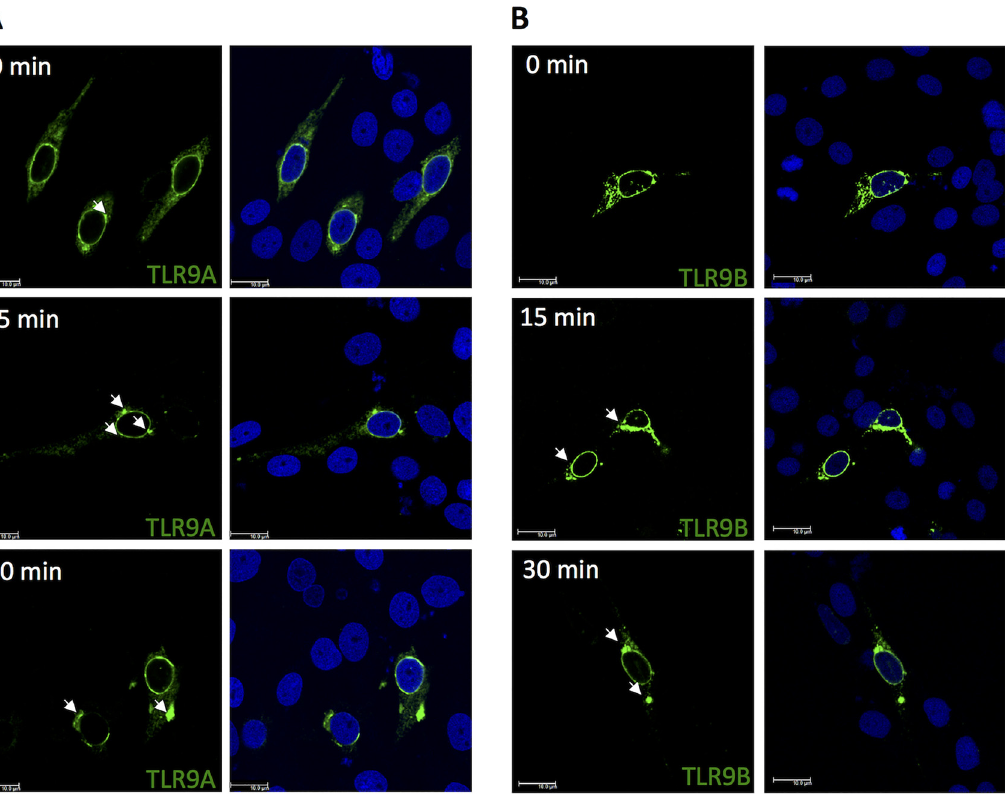
Fig 4. Mobilization of gTLR9A and gTLR9B upon stimulation with CpG ODN. (A) In non-stimulated cells (0 min), gTLR9 is primarily localized perinuclearly in a diffused interconnected web pattern resembling that of the ER. Upon stimulation with ODN, TLR9A gradually formed large aggregates at the location of the presumed endosome. (B) gTLR9B exhibited a pattern similar to that of gTLR9A. These results indicate that both gTLR9A and 9B can be mobilized from the perinuclear area to the endosome. The exact location of the endosome was verified as shown in Fig 6. Results are presented as the observation of at least 100 transfected cells from one representative experiment out of